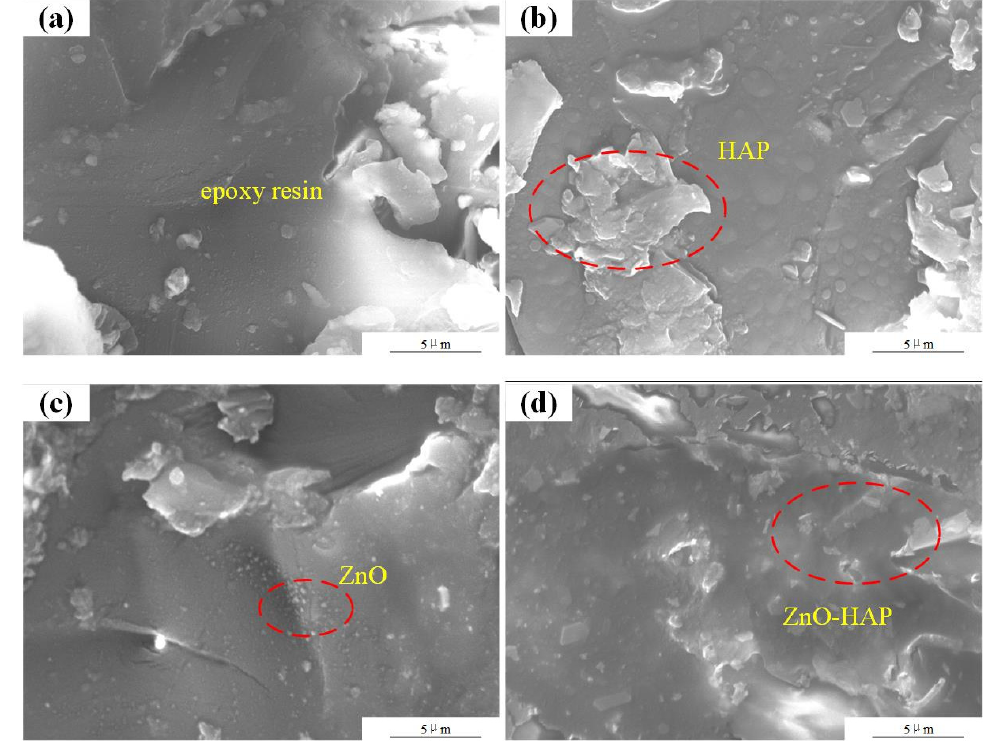
Figure 7. SEM morphologies of cross-section coatings: ( a ) pure epoxy resin, ( b ) HAP coating, ( c ) ZnO coating, and ( d ) ZnO-HAP (65 wt.% ZnO + 35 wt.% HAP)/epoxy resin coating.